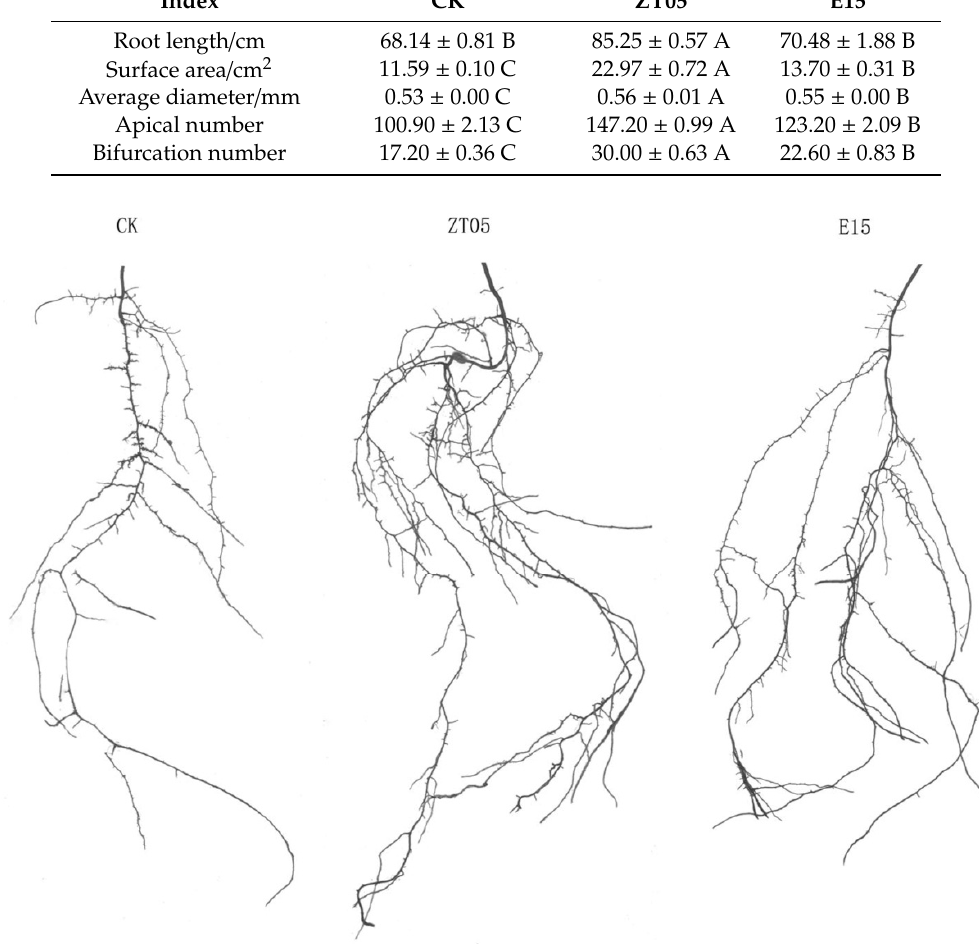
Figure 2. E ff ects of Trichoderma inoculation on seedling root structure of CK, ZT05, E15. CK: inoculation with PD blank culture medium. ZT05: single inoculation with T. virens ZT05. E15: single inoculation with T. harzianum E15.